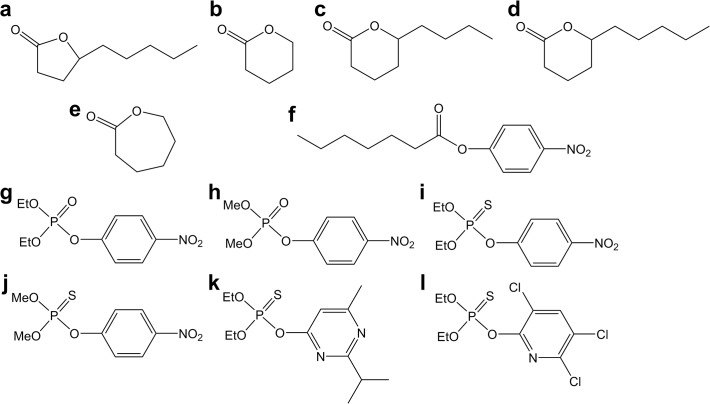
Structures of the substrates used in this study.(a) γ-hexyl-γ-butyrolactone; (b) δ-valerolactone; (c) δ-nonalactone; (d) δ-decanolactone; (e) ε-caprolactone; (f) p-nitrophenyl caprylate; (g) ethyl-paraoxon; (h) methyl-paraoxon; (i) ethyl-parathion; (j) methyl-parathion; (k) diazinon; (l) chlorpyrifos.